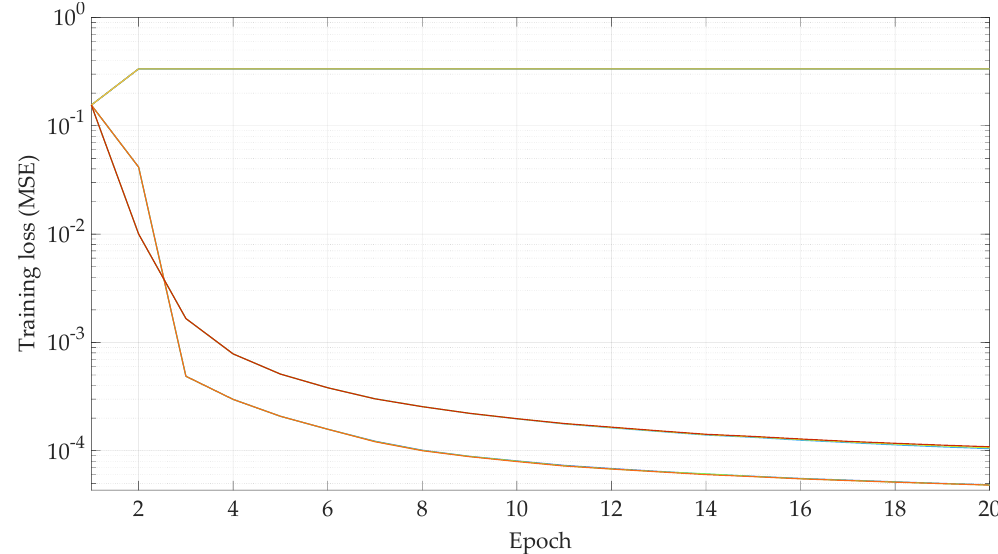
Figure 13. Training loss with respect of the training epoch for the hyper-parameter optimization. [ lr max = 10 − 3 ,drop = 1.1 ] , [ lr max = 10 − 4 ,drop = 1.1 ] , [ lr max = 10 − 5 ,drop = 1.1 ] , [ lr max = 10 − 3 ,drop = 1.3 ] , [ lr max = 10 − 4 ,drop = 1.3 ] , [ lr max = 10 − 5 ,drop = 1.3 ] , [ lr max = 10 − 3 ,drop = 1.5 ] , [ lr max = 10 − 4 ,drop = 1.5 ] , and [ lr max = 10 − 5 ,drop = 1.5 ] .